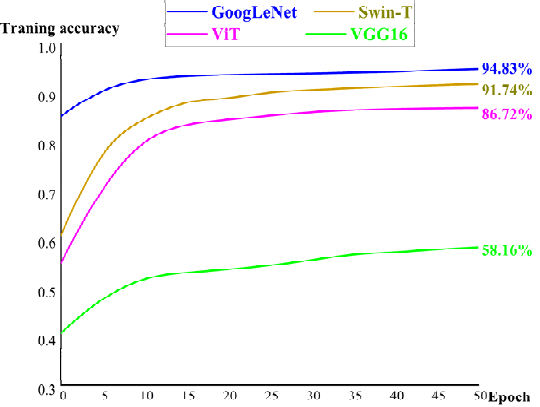
Figure 3. Training accuracy of four algorithms (VGG, ViT, Swin-T, and GoogLeNet).